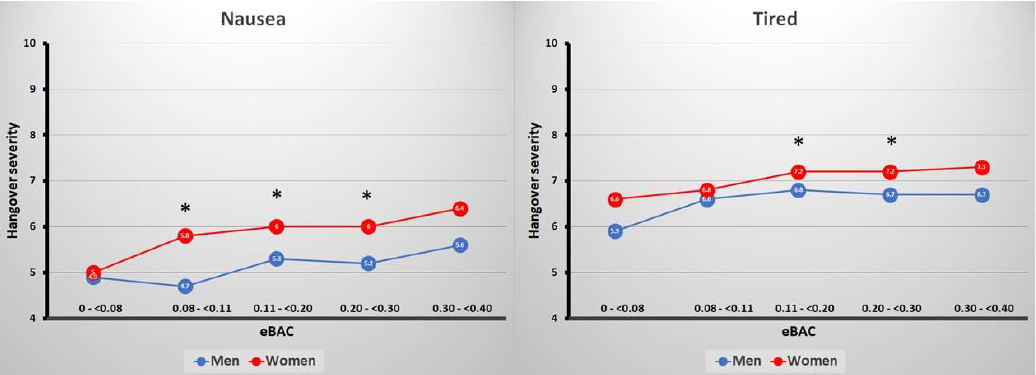
Figure 1. Severity scores for nausea and being tired for men and women across eBAC ranges. Significant differences ( p < 0.002) are indicated by *. Abbreviation: eBAC = estimated blood alcohol concentration.